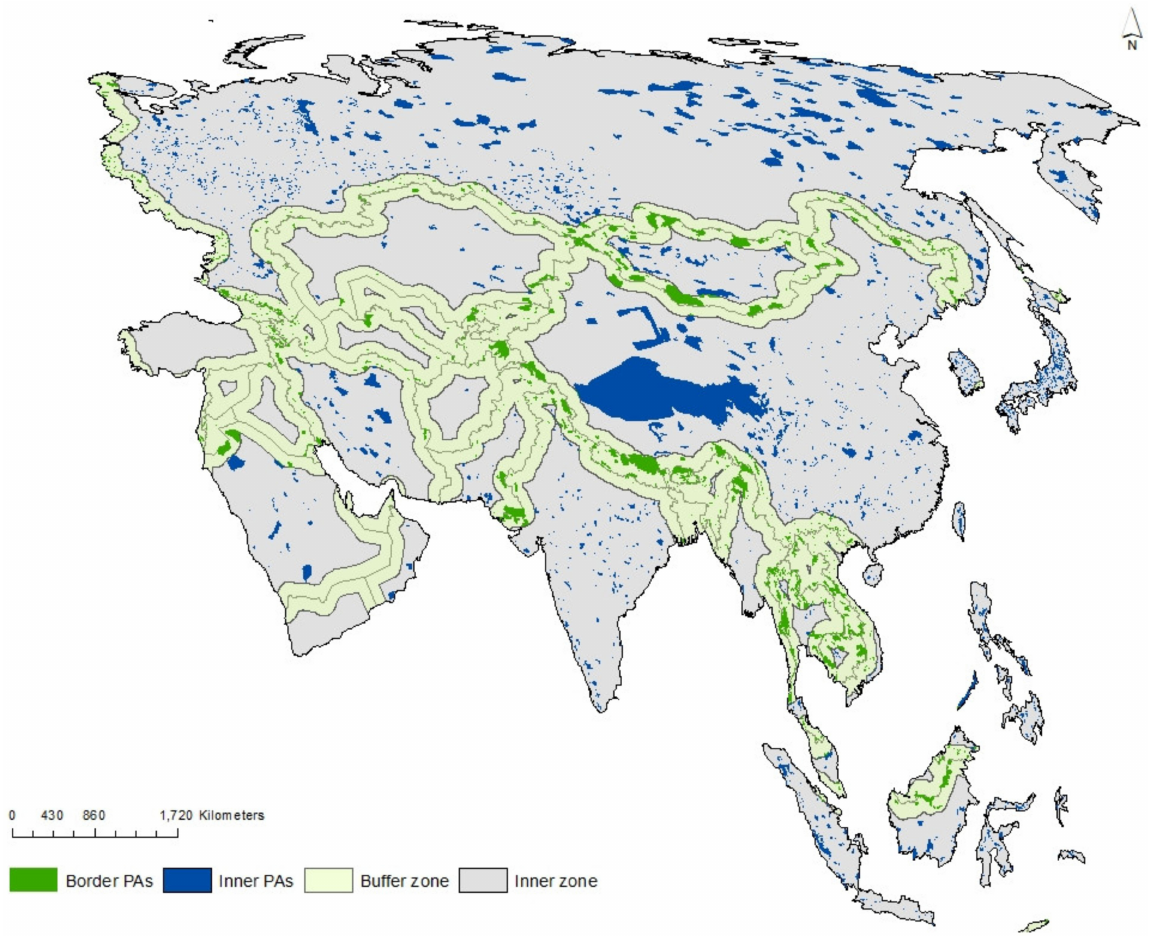
Figure 1. Extent of the study area with a border buffer of 125 km (light green) applied to each country in the study area (Asia continent). PAs in the countries’ interior zones (dark blue) and PAs in the border zones (dark